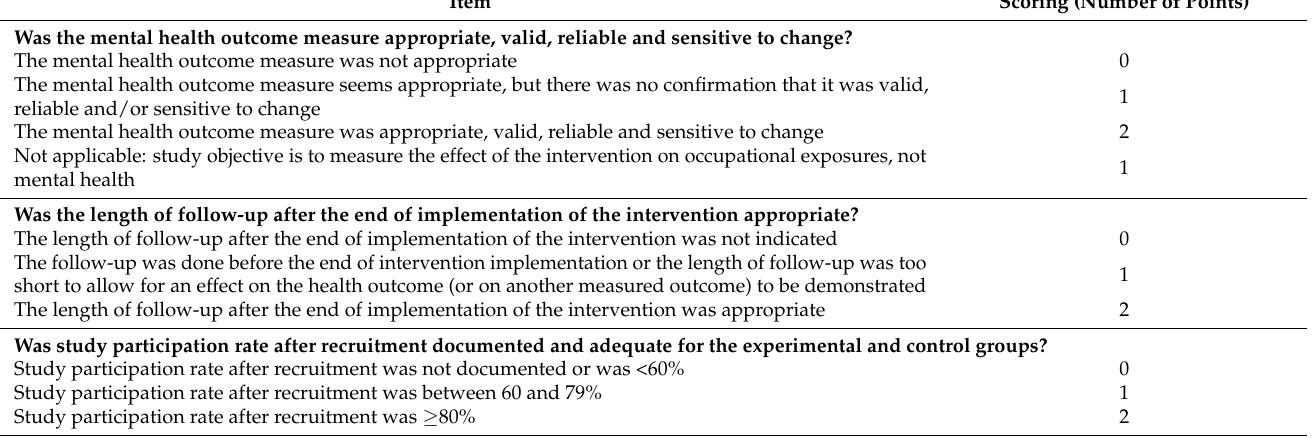
Table A2. Cont. Item Scoring (Number of